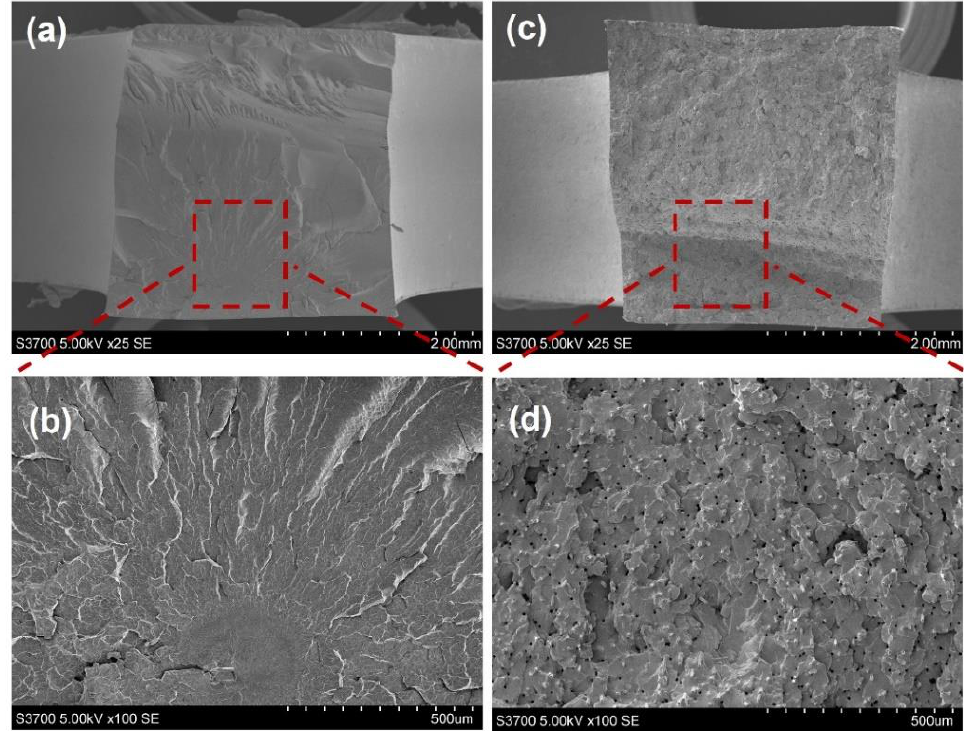
Figure 6. The structure of injection-moulded polyamide: ( a ) 25 × and ( b ) 100 × ; injection-moulded SFRN: ( c ) 25 × and ( d ) 100 ×